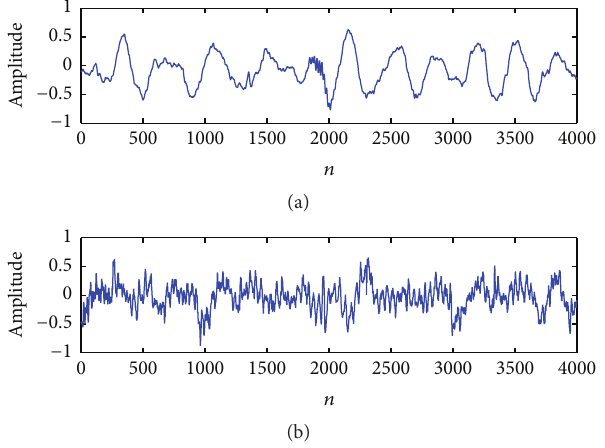
Figure 1: Waveform of seismic waves of two kinds of targets: (a) tracked vehicle and (b) wheeled vehicle.